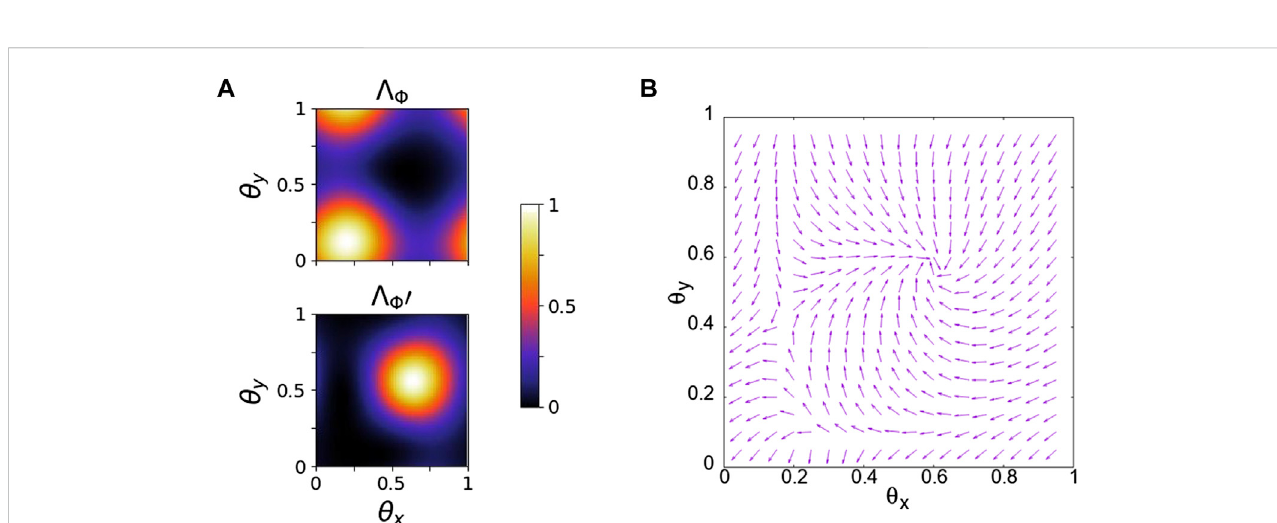
FIGURE 7 Plot of (A) reference gauge fi elds Λ Φ , Λ Φ ′ , and (B) argument fi eld Ω as a function of the twist angles for the case of a dipolar interaction with strength V = 2 J = 0.02 U . In the region, where Λ Φ ′ ≠ 0 and Λ Φ = 0, we see a vortex in the Ω fi eld with a phase accumulation of 2 π around it. Similarly, in the complementaryregion,we seeananti-vortexinthe Ω fi eld.Thus, thereisonlysingle-branchvortex ineachregion,whichsigni fi esthatthemany-bodyChern number is equal to